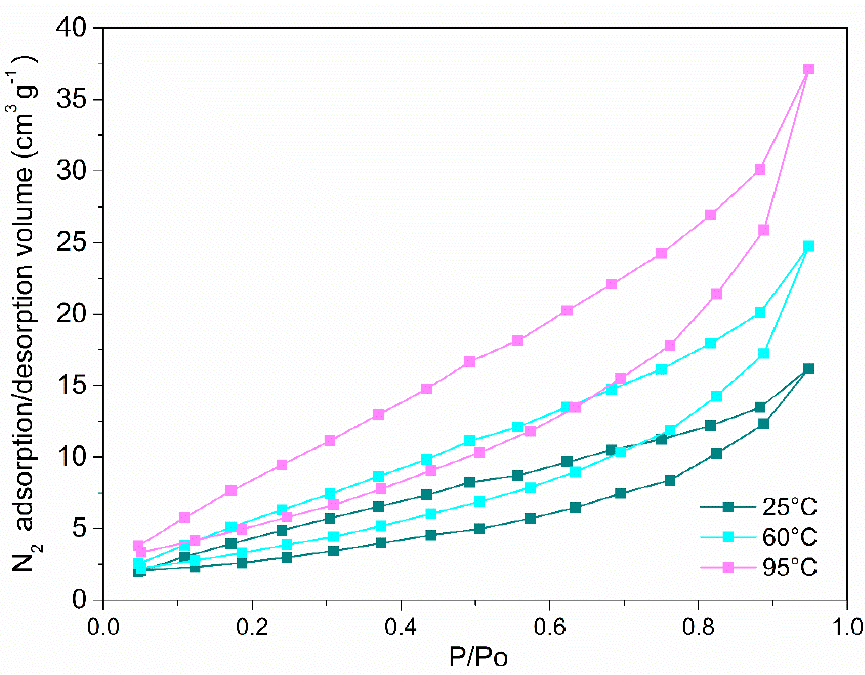
Figure 6. Adsorption / desorption isotherms of as-deposited C(OH) 2 at 25, 60, and 95 ◦ C.